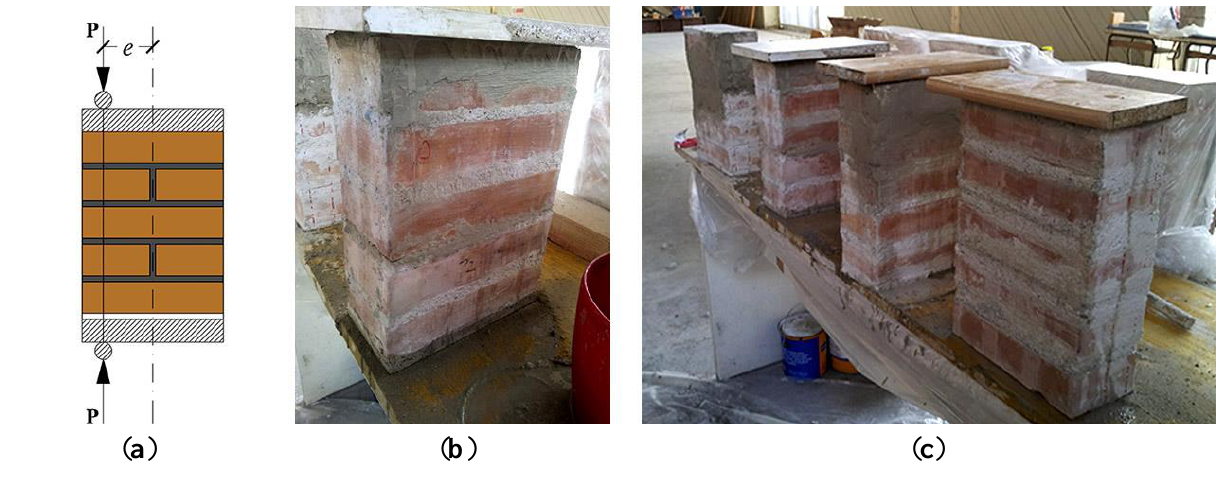
Figure 4. ( a ) Eccentric load test set-up; ( b , c ) Repairing the tested URM